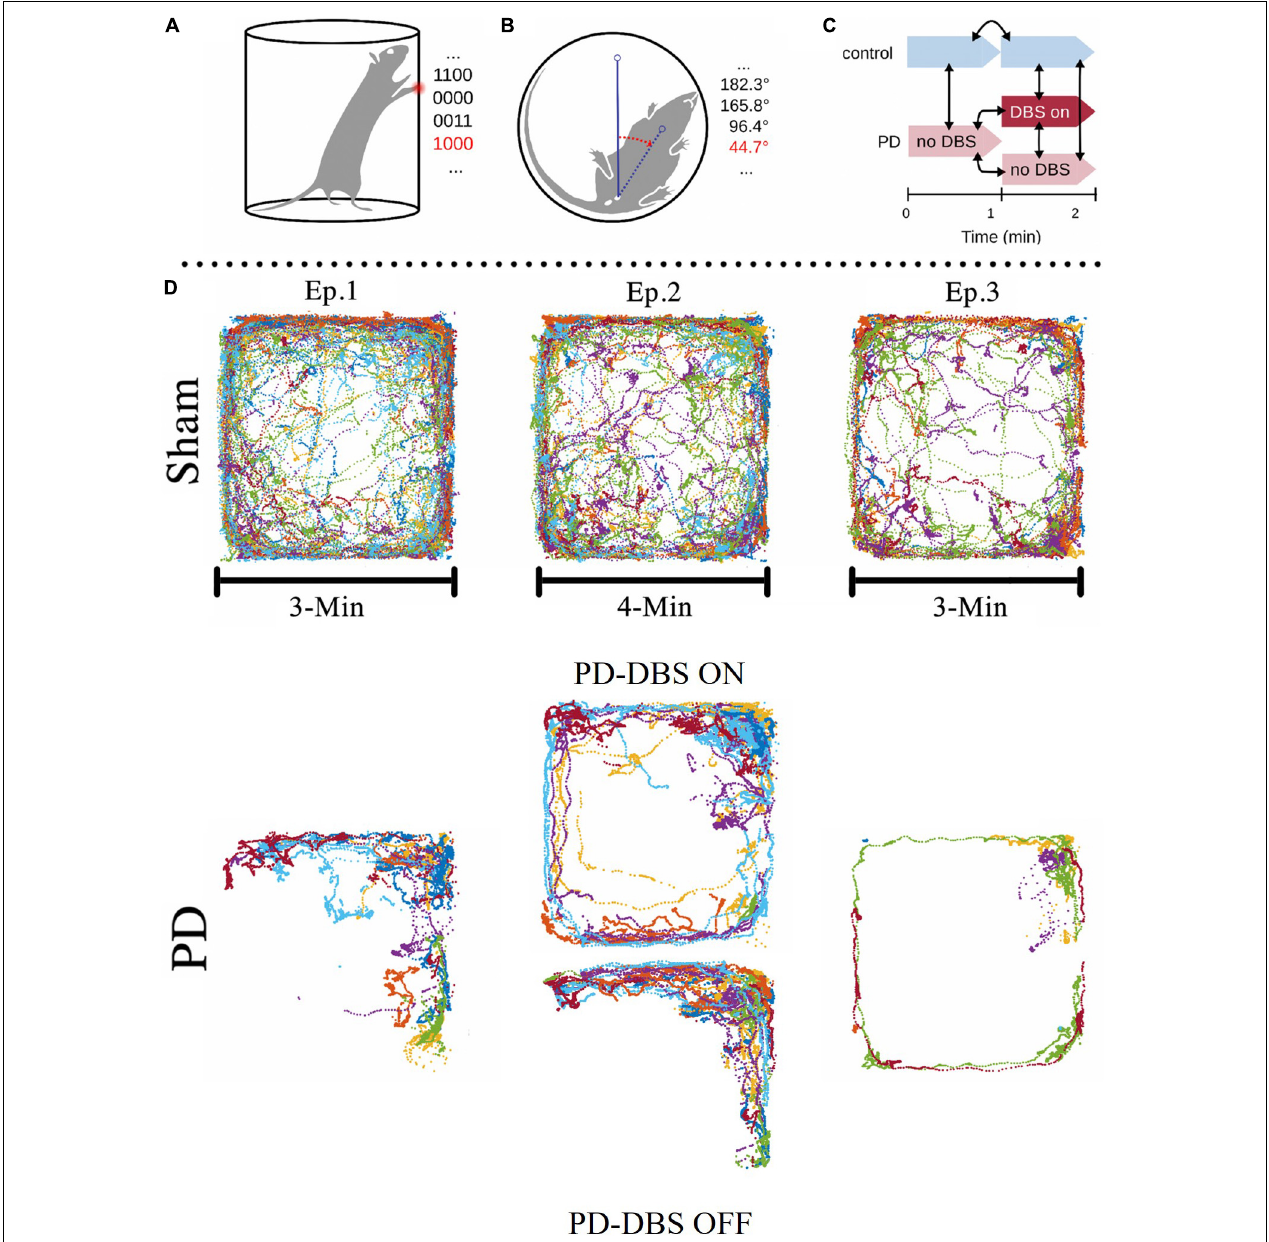
FIGURE 3 | Depictions of the cylinder test and open field test experimental setups. (A,B) The body angle of the animal and the position of its forepaws were measured and the latter was recorded using a binary code. The first two digits of the 4-bit code represent whether the forepaws were touching the cylinder walls and the last two represent whether they were touching the cylinder floor (e.g., 1100 = both front paws on wall, 0000 = rearing with no support, 0011 = both front paws on floor, 1000 = left paw on wall and right paw not in contact). (C) The animals were monitored for 2 min. A subgroup of PD animals received DBS treatment at the onset of the second minute, while the rest of the PD group remained untreated. (D) Open field area, a 74 cm × 74 cm square box, with the exploratory activities of different PD and Sham rats during 10 min superimposed. Note how sham rats explore most of the area available to them (with a tendency to avoid the center which is a natural reaction for rats), whereas unstimulated PD rats remain on the corners and explore much less than sham rats. Notice the significant difference in the trajectories between stimulated PD rats (episode 2, top) and non-stimulated PD rats [episode 1, 2 (bottom) and 3]. This shows that DBS considerably increases the rats’ ability or motivation to explore and corrects major motor impairments. Figure adapted from Mottaghi (2020).